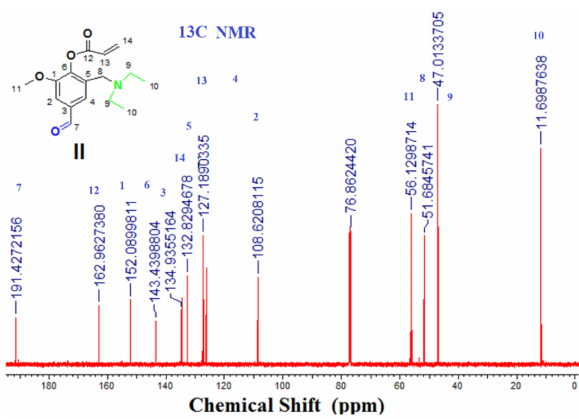
Figure 5. 13 C-NMR spectrum (CDCl 3 ) of